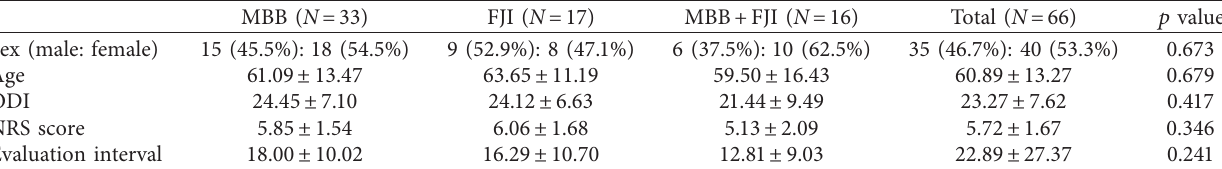
Table 1: Preintervention demographic characteristics of patients.